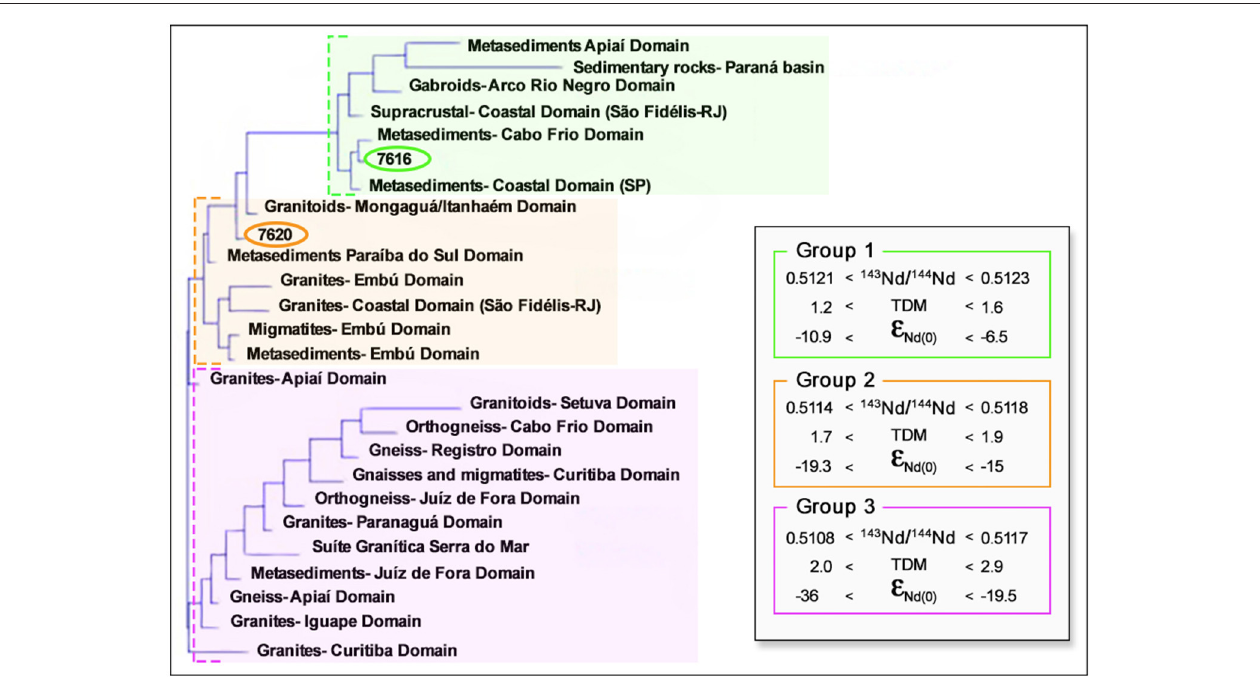
FIGURE 5 | Dendogram elaborated from cluster after PCA analyses on Nd isotopic data, showing three major groups: Group 1 with 143 Nd/ 144 Nd from 0.5121 to 0.5123, T DM from 1.2 to 1.6 and ε Nd(0) from − 10.9 to − 6.5; Group 2 with 143 Nd/ 144 Nd from 0.5114 to 0.5118, T DM from 1.7 to 1.9 and ε Nd(0) from − 19.3 to − 15; Group 3 with 143 Nd/ 144 Nd from 0.5108 to 0.5117, T DM from 2.0 to 2.9 and ε Nd(0) from − 36 to − 19.5.